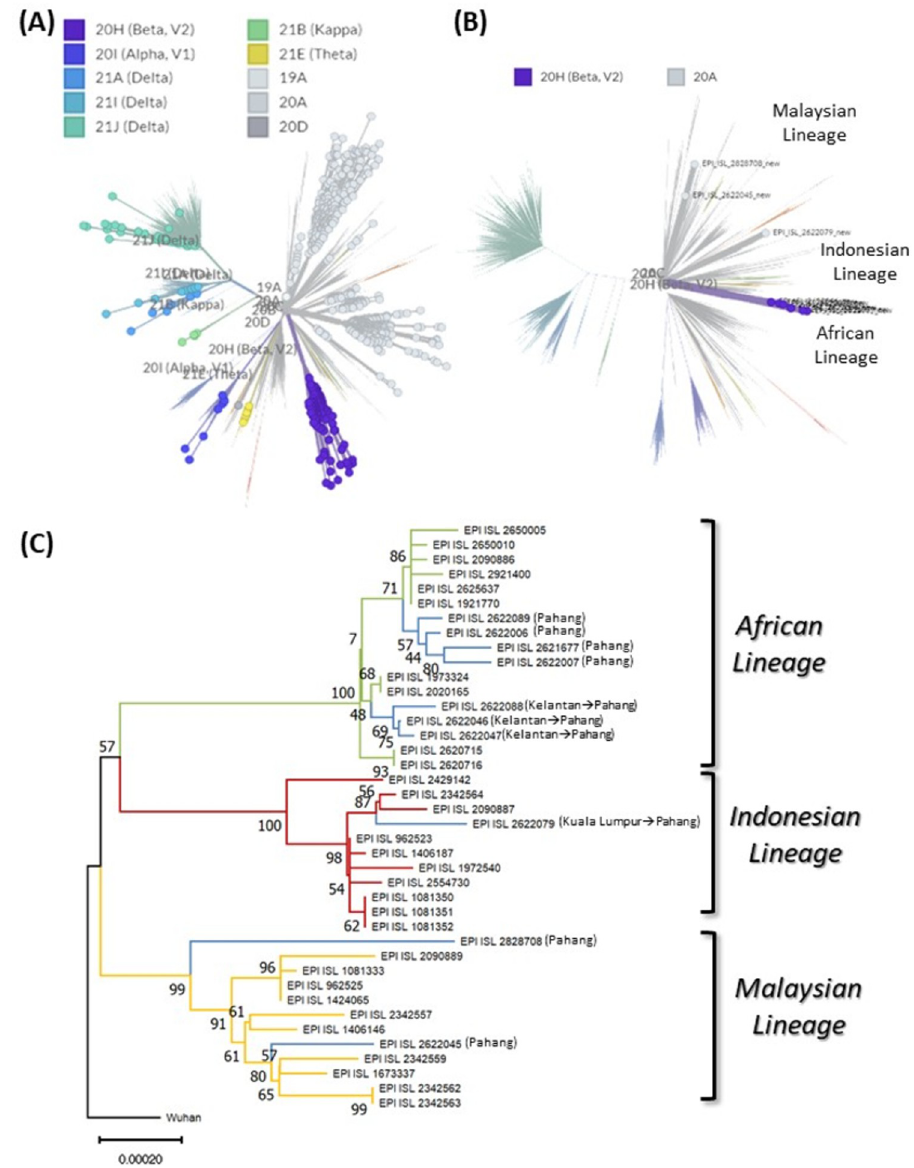
Fig 2. Phylogenetic tree of 986 complete genomes of Malaysia SARS-CoV-2 D614G variants in 2021. (A) Nextstrain clade distribution (inset) of 986 complete genomes of Malaysia SARS-CoV-2 D614G variant (filled circles) (B) Nextstrain clade and lineage distribution (inset) of the Pahang SARS-CoV-2 D614G variants (filled circle). Please see S2 File for the fully annotated tree (C) Phylogenetic relationship of the Pahang SARS-CoV-2 D614G variants (blue branches) with the selected neighbouring representatives (in Nextstrain clade tree) of SARS-CoV-2 genome sequences of African (green branches), Indonesian (red branches) and Malaysian lineages (yellow branches). The tree is reconstructed by Neighbor Joining (NJ) method with 1000 bootstrap replicates. Bootstrap values are indicated at nodes. Note the strong bootstrap support (99%-100%) at the common node of each lineage. In parenthesis city of